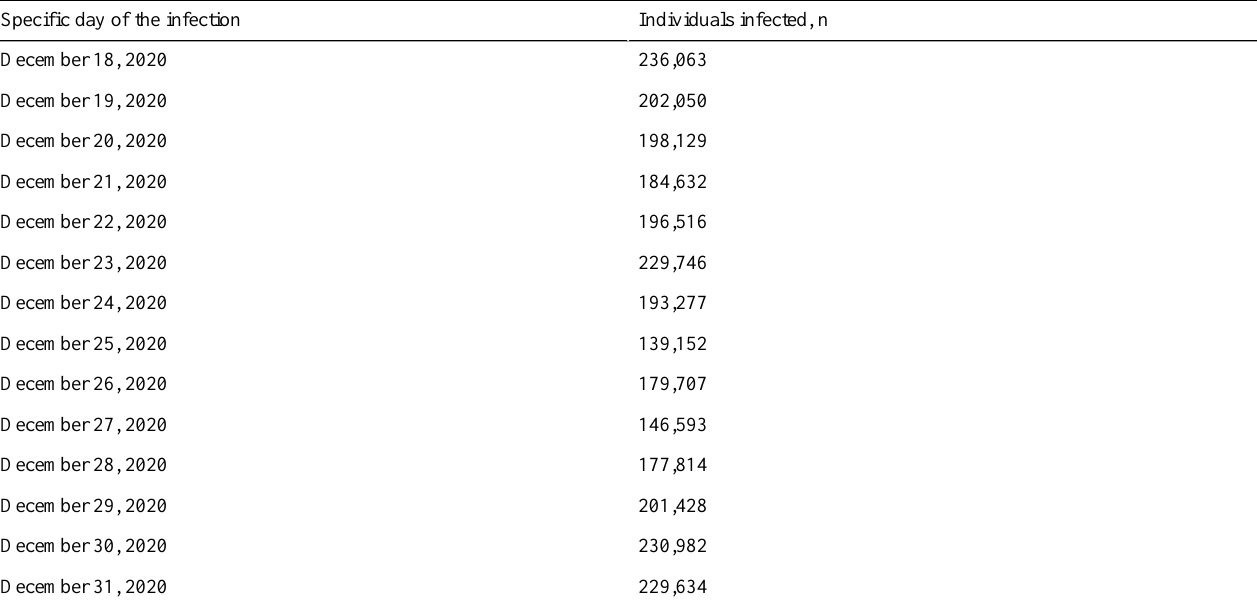
Table 4. Timing of the infection in the 2 weeks preceding the start of our simulation, such that our agents can be initialized at the appropriate state of their infection.